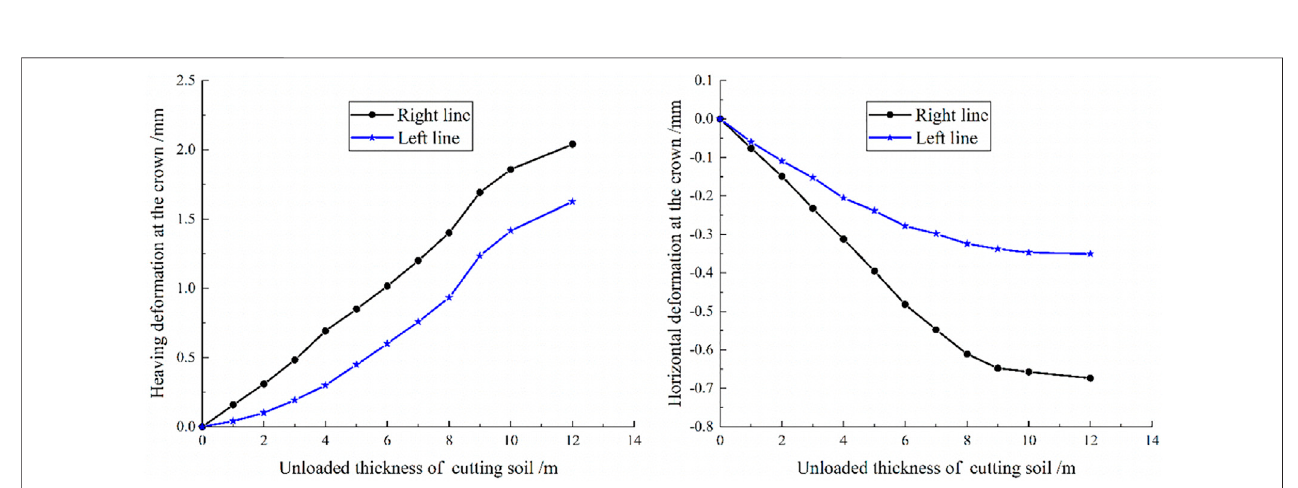
FIGURE 12 | The shape of the deformed metro tunnel structure after unloading the cutting soil (the deformation is magni fi ed 2000 times).